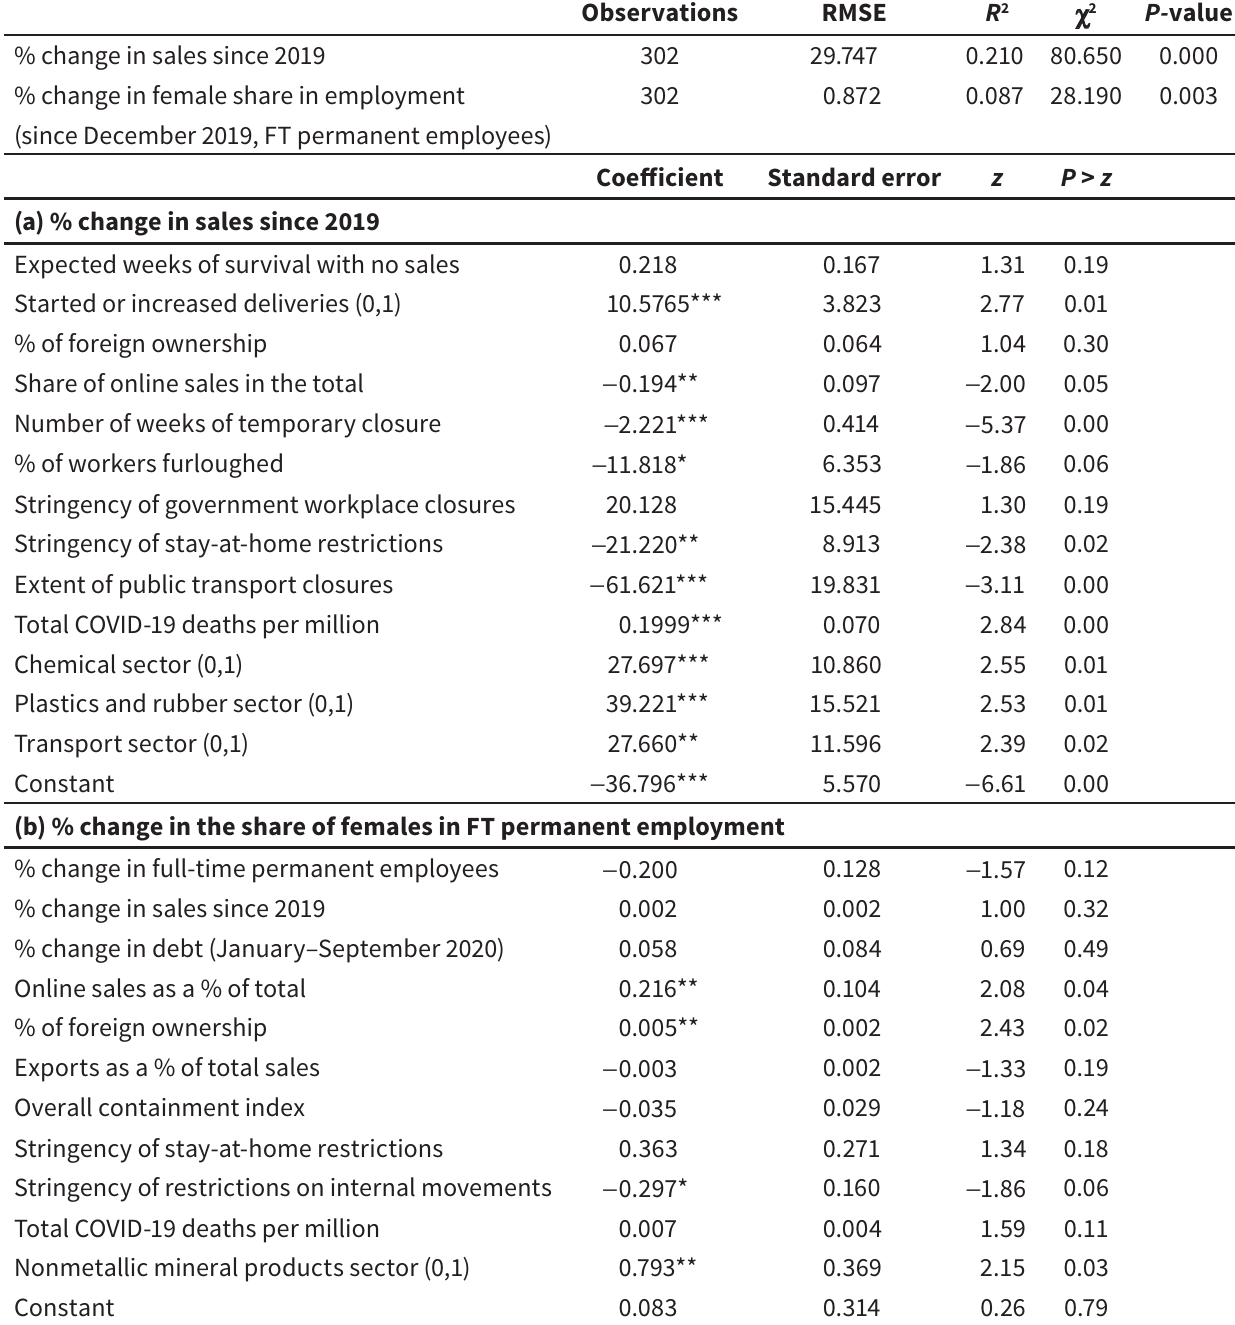
SURE estimation for changes in sales and the share of females in employment